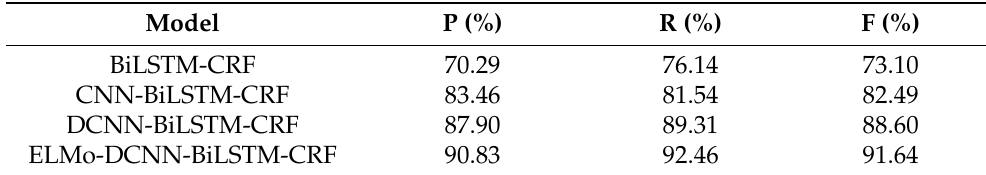
Table 3. Experimental results of three